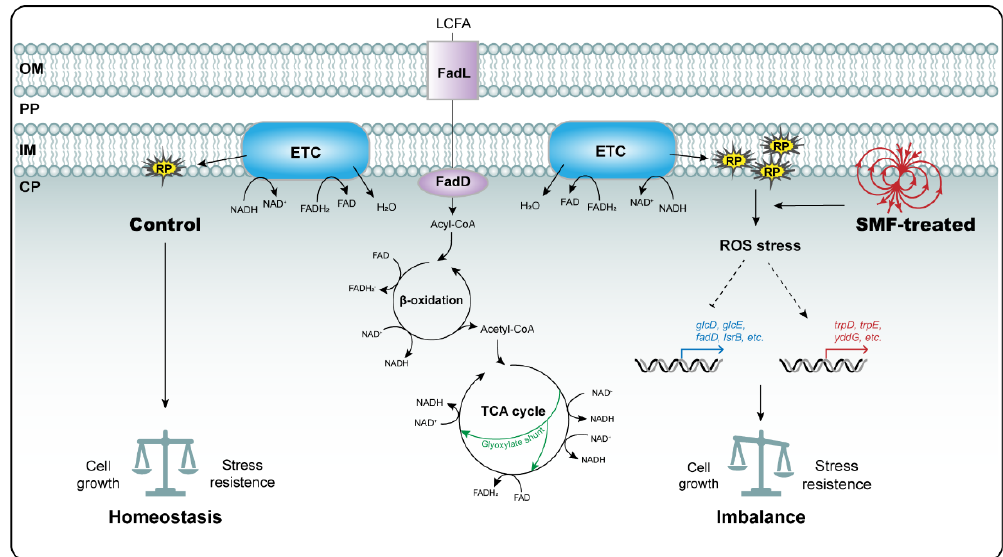
Figure 5. A model proposed to explain the biological SMF effects on E. coli growth. The detailed explanation is described in the text. Upregulated genes were shown with red line and downregulated genes were shown with blue line. LCFA: long-chain fatty acids; OM: outer membrane; PP: periplasm; IM: Inner membrane; CP: cytoplasm; ETC: electron transport chain; RP: radical pairs. Supplementary Materials: The followings are available online at www.mdpi.com/xxx/s1, Table S1: An overview of the RNA sequencing quality of all samples, Table S2: The total number of genes detected by RNA-seq, Table S3: DEGs were selected using p value ≤ 0.05, Table S4: The list of DEGs with the criteria of |Log 2 FC| ≥ 0.58496 and p value ≤ 0.05, Table S5: Group information and total ion chromatogram of samples for LC-MS, Table S6: The total metabolites identified by metabolomic analysis in E. coli , Table S7: The 55 DAMs were selected by the criteria with the significant level ( p ≤ 0.05 and VIP ≥ 1) between SMF-treated and control bacteria, Table S8: Effect of SMF on phospholipid contents, Table S9: Primers used in this